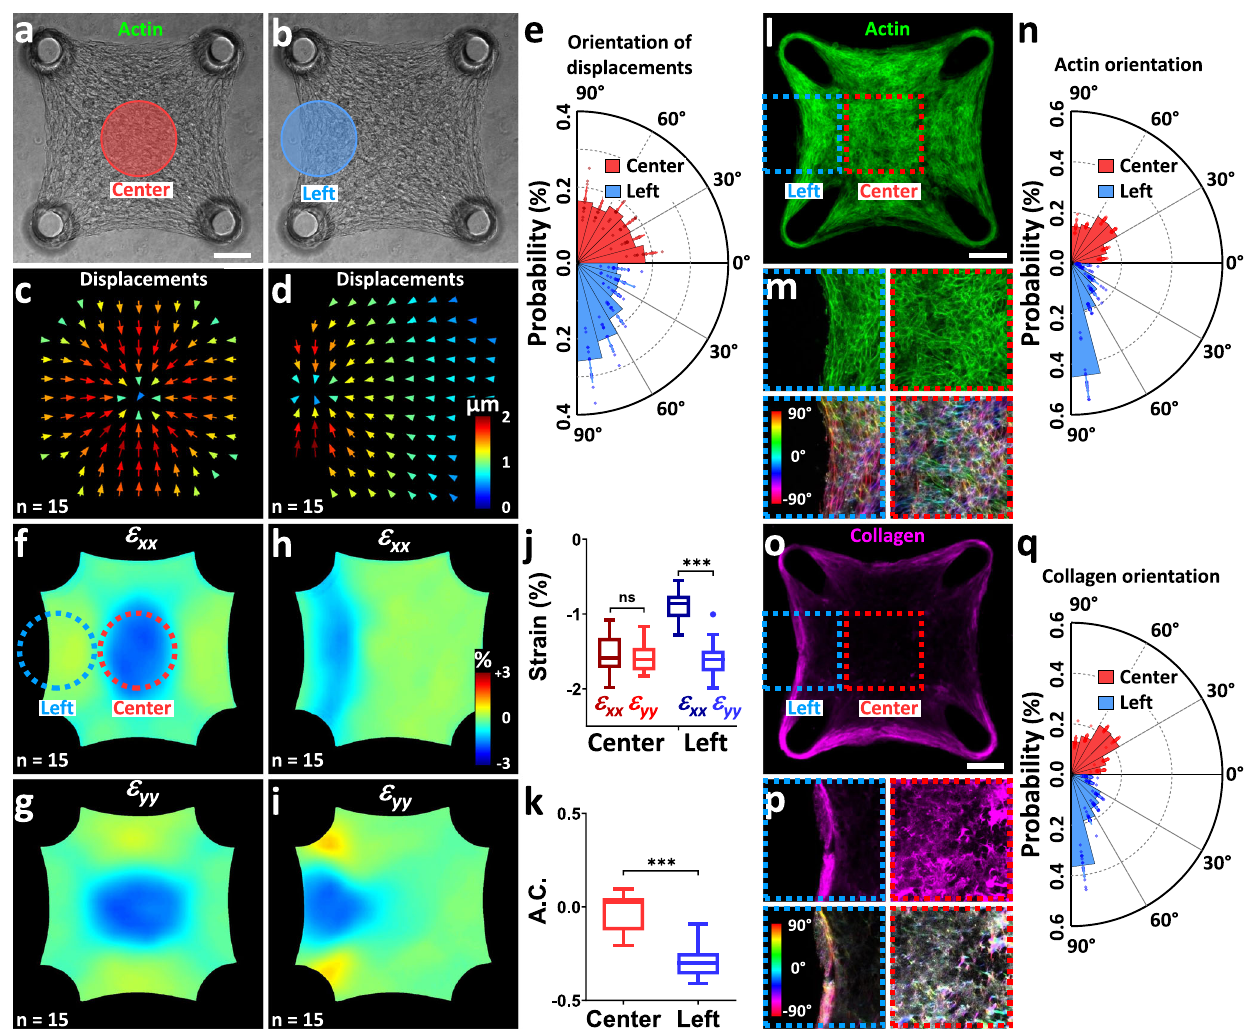
Fig. 5 | Optogenetically-mapped mechanical heterogeneities correlate with actin and collagen architecture. a Representative square microtissue where the red ( a ) and blue ( b ) discs represent the centered and eccentric 200 µ m diameter stimulation areas, respectively. Corresponding average displacement fi elds for the centered( c )andeccentric( d )stimulations.Forreadabilityreasons,onlyhalfofthe vectors are represented. e Polar plot of the orientations of the displacement vec- tors. Data are presented as mean±SD with n =15 microtissues over 2 independent experiments, superimposed with a dot plot of the data distribution. Resulting average strain fi elds for centered ( ε xx in f , ε yy in g ) and eccentric ( ε xx in h , ε yy in i ) stimulations. Comparison of the average strain amplitudes ( j ) and anisotropy coef fi cientA.C. k intheareasofstimulation.DataarepresentedasTukeyboxplots (i.e. the box extends from the 25th to 75th percentiles, the median is plotted as a line inside the box and the whiskers extend to the most extreme data point that is nomorethan1.5timestheinterquartilerangefromtheedgeofthebox)with n =15